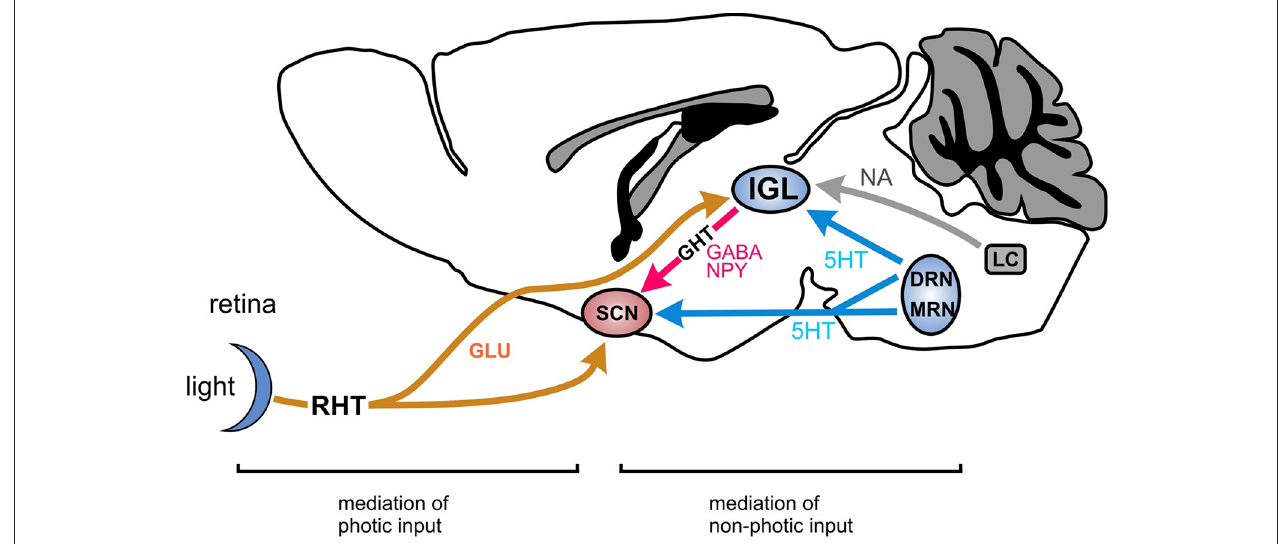
FIGURE 1 | Main pathway of the circadian system in mammals involving the SCN and the IGL. The principal pathway for photic entrainment is the retinohypothalamic tract (RHT), a glutamatergic projection from the retina to the suprachiasmatic nucleus (SCN), and the intergeniculate leaflet (IGL). Non-photic entrainment cues converge on the IGL from the dorsal raphe nuclei (DRN) and the locus coeruleus (LC) and other nuclei involved in the regulation of sleep, arousal and activity. The IGL integrates these photic and non-photic inputs and conveys this information to the SCN via the geniculohypothalamic tract (GHT) which is a GABA-NPY projection. GLU, glutamate; GABA, gamma-aminobutyric acid; NPY, neuropeptide Y; 5HT, serotonin; MRN, mediane raphe nucleus.